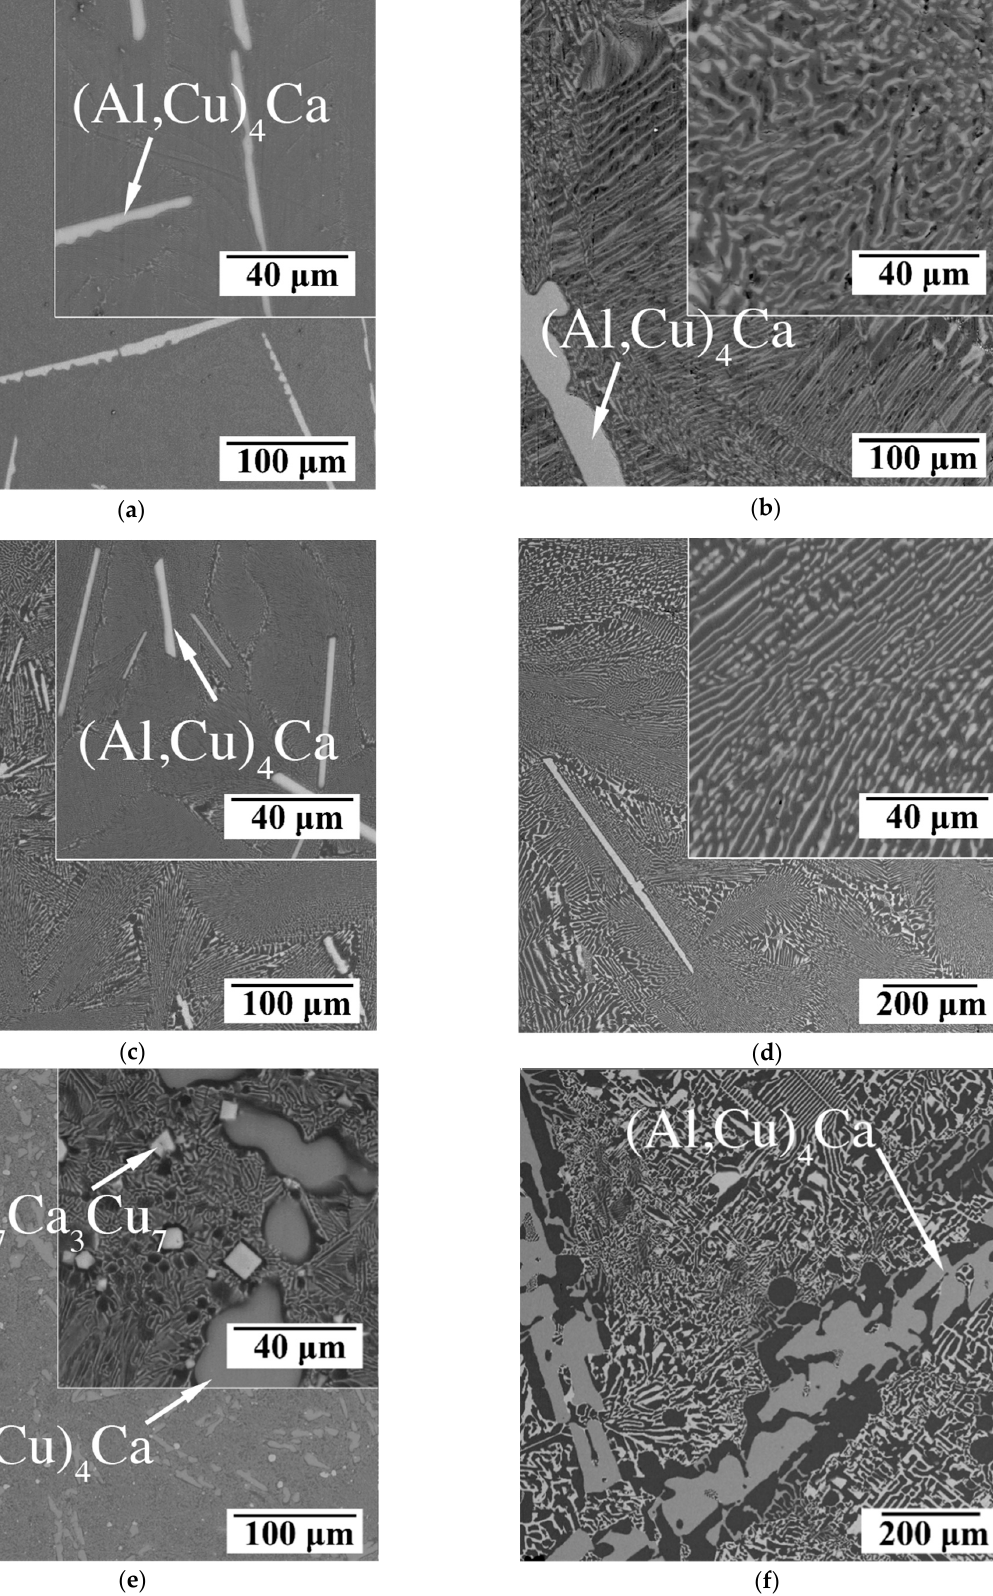
Figure 2. SEM microstructure of the alloys: ( a , b ) Al1.0Cu8.0Ca, ( c , d ) Al2.2Cu6.7Ca, ( e , f ) Al14Cu6.0Ca for cooling rates of ( a , c , e ) 10 K/s and ( b , d , f ) 0.02 K/s. (backscattered electron (BSE) images). Table 2. Chemical composition of the phases detected in the alloys obtained at various cooling rates (Vs) upon solidification. Chemical Composition, at.%